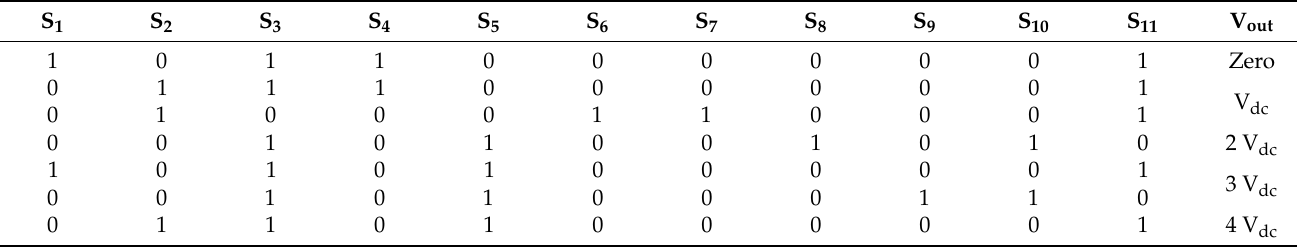
Table 1. Fault management for each